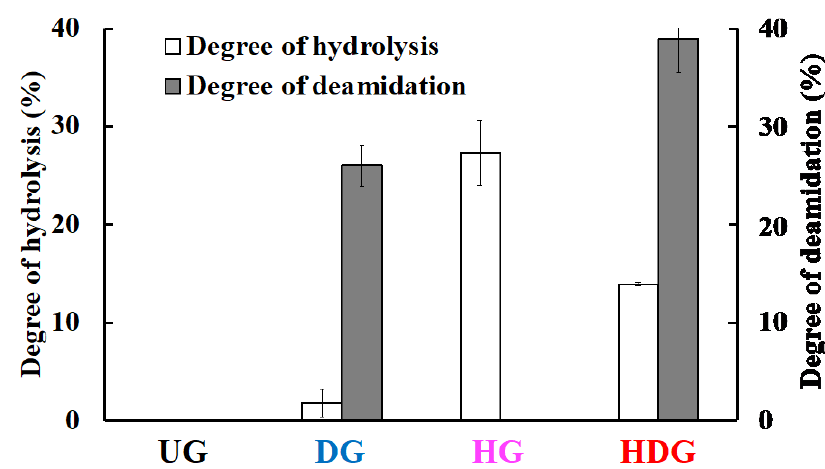
Figure 2. Degrees of deamidation and peptide-bond hydrolysis of wheat gliadins. Each value is the mean of four experiments with SE shown as a vertical bar.